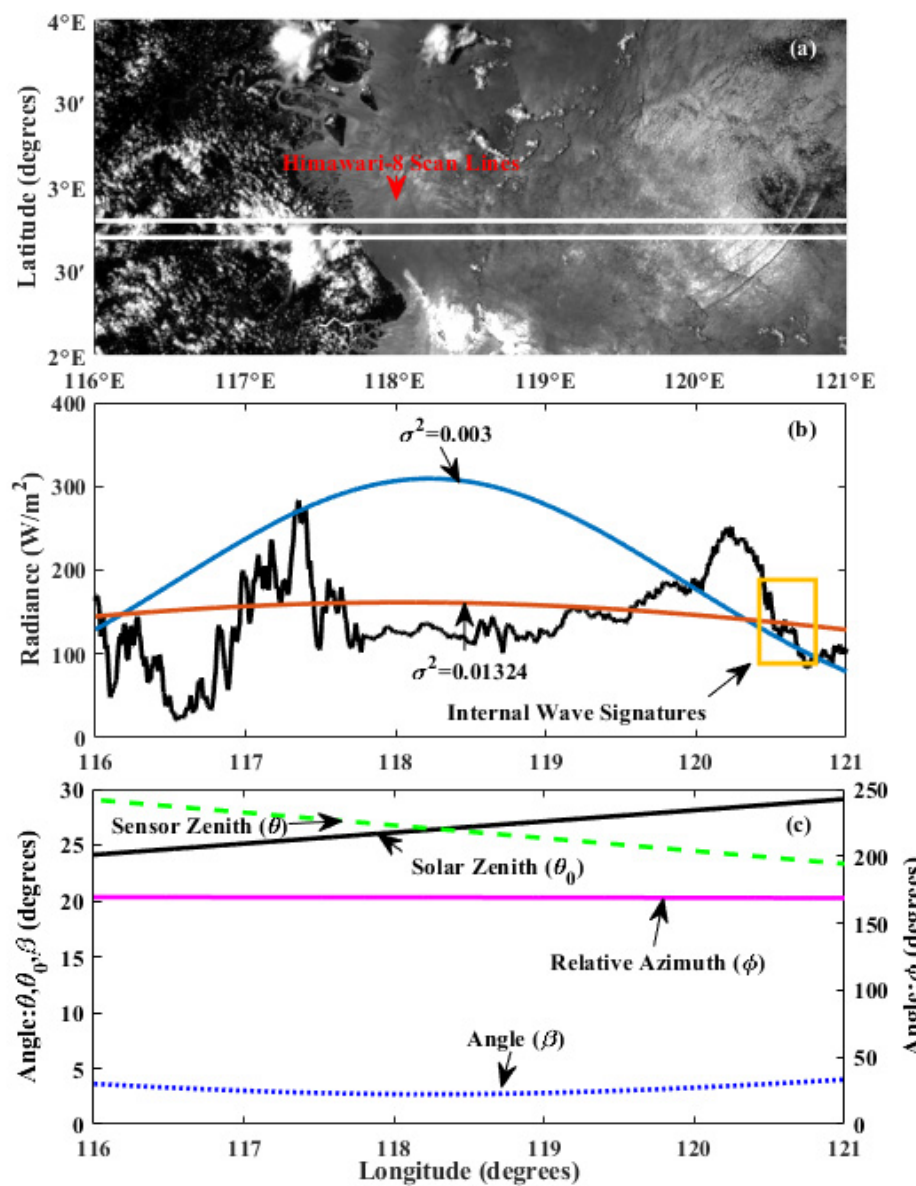
Figure 12. Analysis of the image acquired on 21 September 2020 at 05:40 UTC. ( a ) shows part of the Himawari-8 image of the Celebes Sea acquired on 21 September 2020 at 05:40 UTC, and the white solid line is the scan line of the AHI sensor onboard the Himawari-8 satellite; ( b ) shows curves of the normalized solar radiance calculated with roughness variance ( σ 2 ) values of 0.003 and 0.01324 and the average measured radiance along the scan line, and the yellow box marks the position of the internal solitary waves. The blue and orange curves represent the radiance information of the sea surface background and internal solitary waves, respectively; ( c ) shows the changes in the solar zenith angle ( θ 0 ), sensor zenith angle ( θ ), relative azimuth angle ( ϕ ), and surface facet tilt ( ꞵ ) along the AHI sensor scan line. The solid black line represents the change in the solar zenith angle ( θ 0 ) along the scan line. The green dashed line represents the change in the sensor zenith angle ( θ ) along the scan line. The purple solid line represents the relative azimuth angle ( ϕ ) along the scan line. The blue dotted line represents the change in surface facet tilt ( ꞵ ) along the scan line.